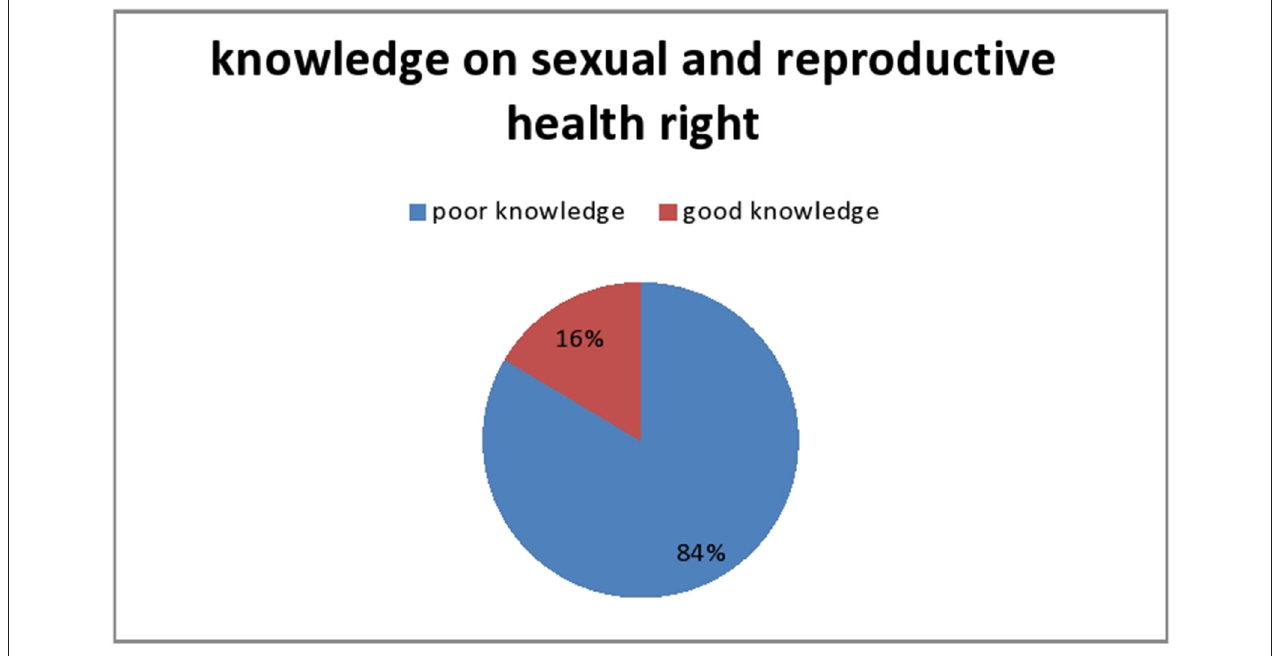
FIGURE 2 | Knowledge on sexual reproductive health rights of regular undergraduate students of University of Aksum, Northwest Ethiopia, 2019G.C.